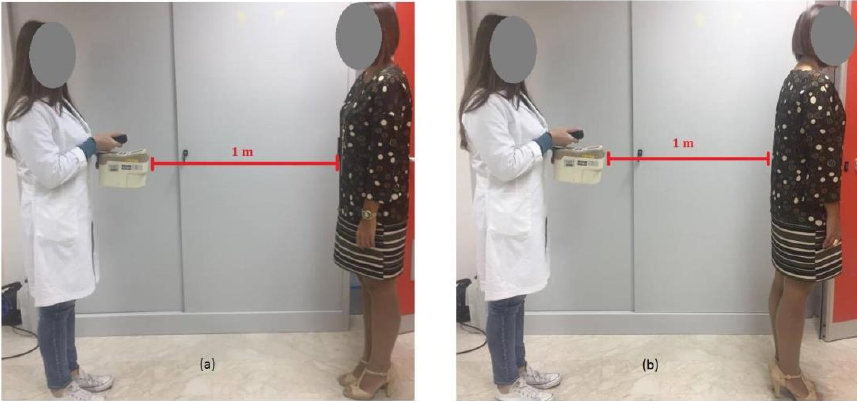
Figure 1. Setup for radioactivity measurements: ( a ) front position (AP) and ( b ) anterior position (PA) positions to the abdomen, at the distance of 1 m.